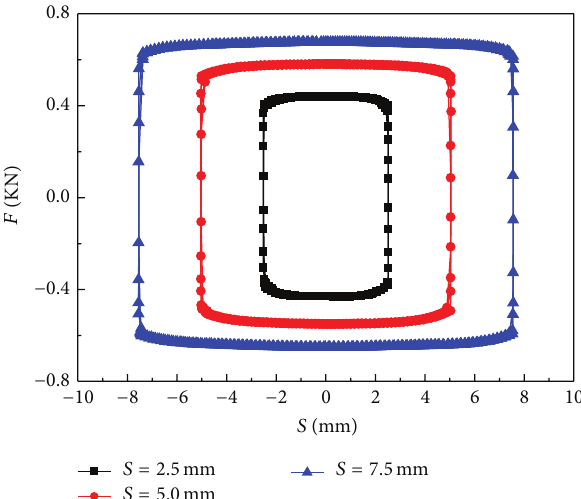
Figure 16: Damping force under different displacements.